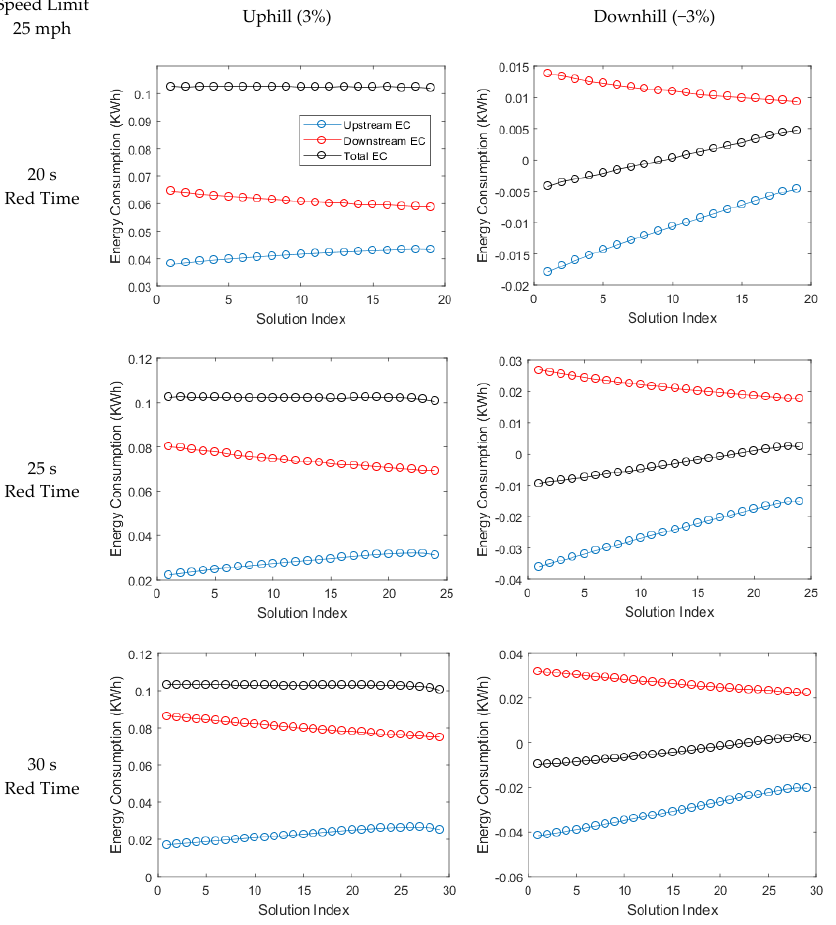
Figure 3. Nissan Leaf BEV Eco ‐ CACC ‐ I energy consumption for a speed limit of 25 mph.